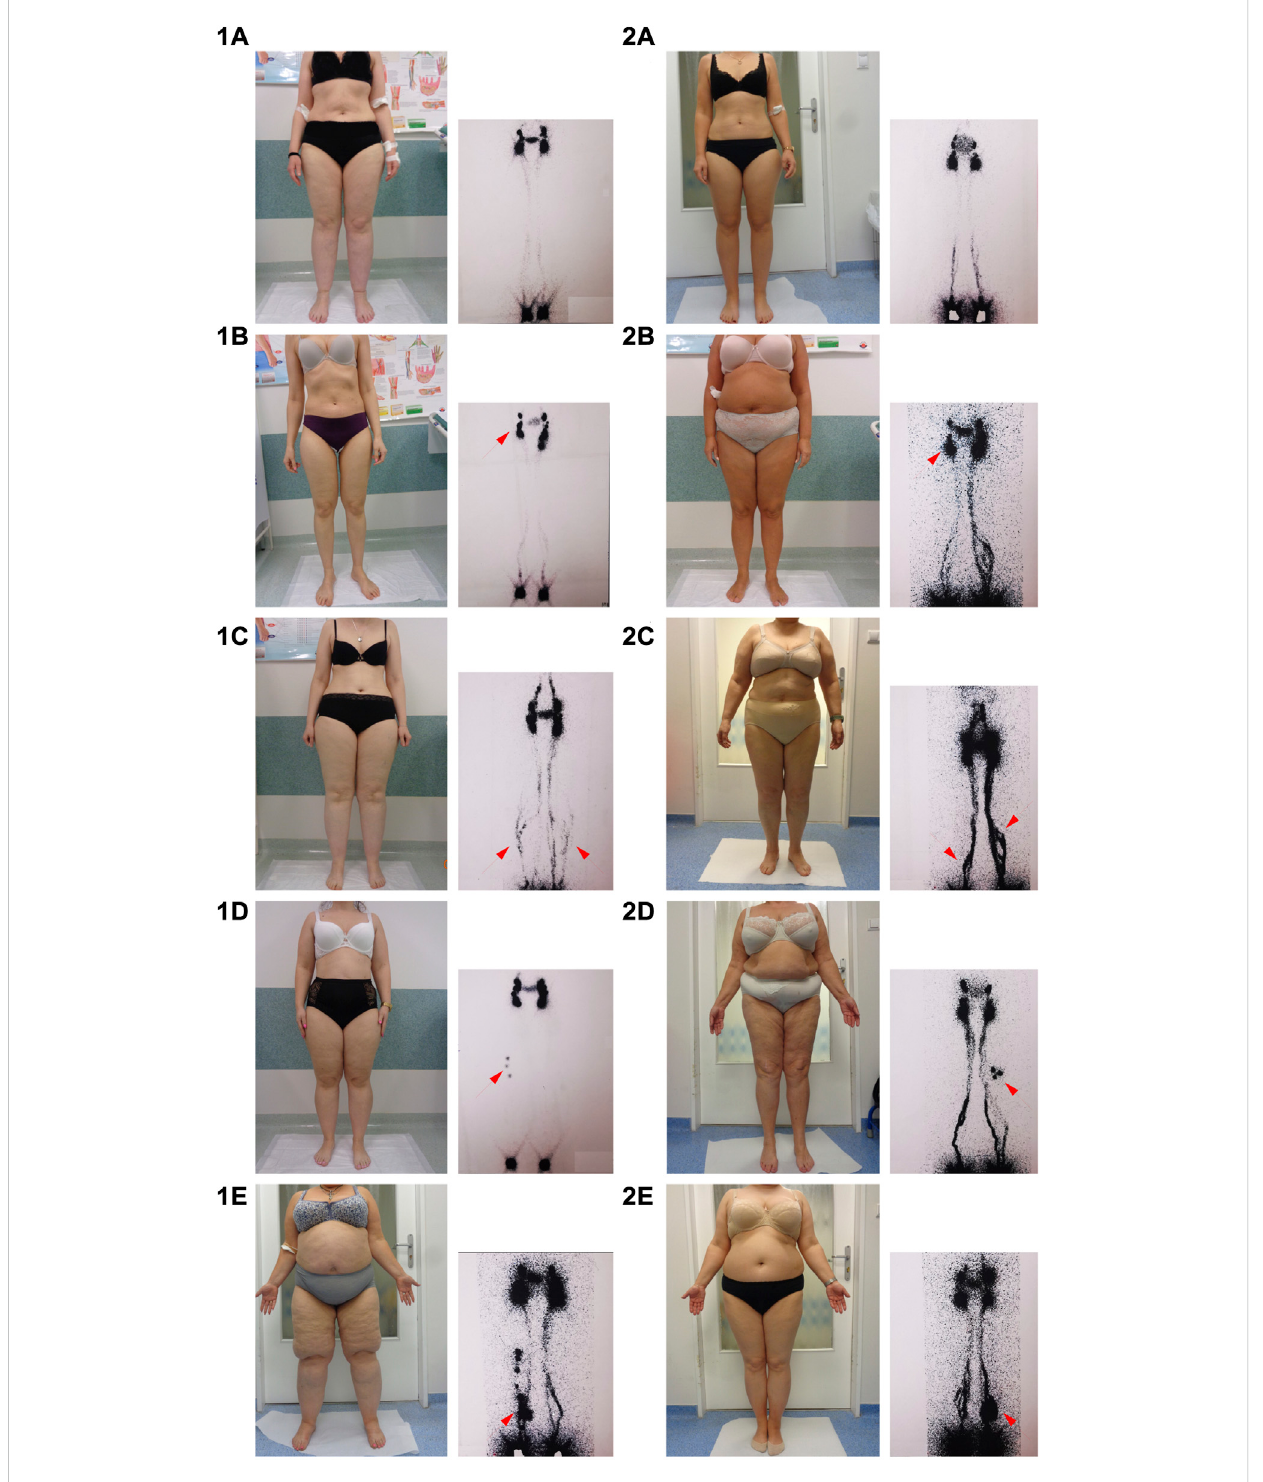
FIGURE 1 Examples of lymphoscintigraphic alterations in the group with lipedema and in the group with overweight/obesity. Arrows indicate sequential lymphoscintigraphic alterations listed in order of severity. However, several lymphoscitigraphic alterations were often observed in one patient. Legend: (1A – E) : lymphoscintigraphy in women with lipedema; (2A – E) : lymphoscintigraphy in women with oveweight/obesity; (1A,2A) : normal lymphoscintigraphy; (1B,2B) : asymmetry in visualization of inguinal lymph nodes; (1C,2C) : additional lymphatic vessels (collateral circulation); (1D,2D) : visualization of popliteal lymph nodes; (1E,2E) : dermal back fl